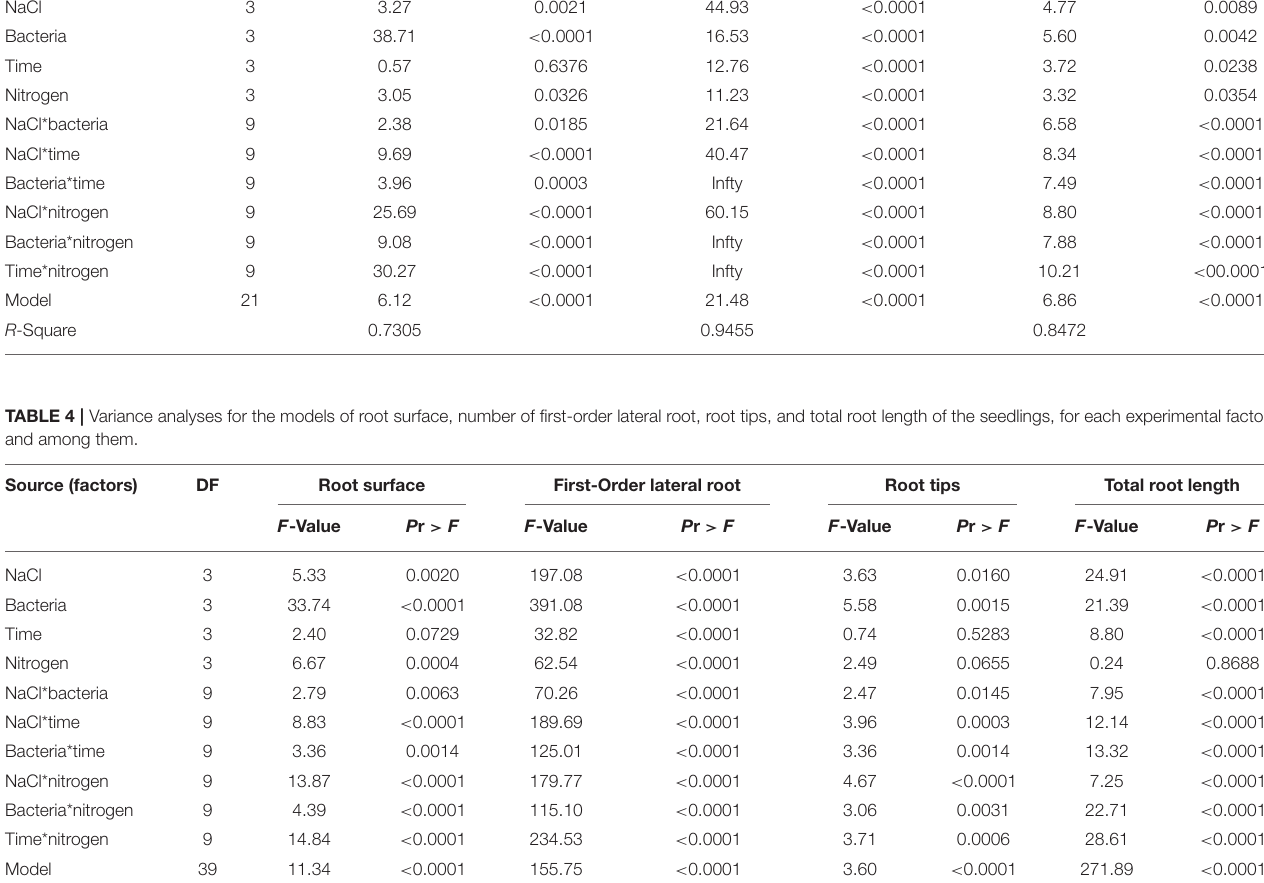
TABLE 3 | Variance analyses for the models of shoot length, fresh weight, and dry weight for each experimental factor and among them. Source (factors)